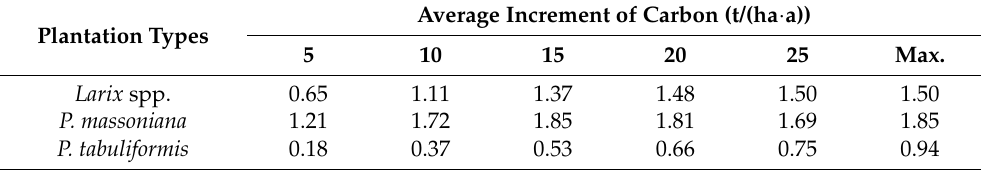
plantation types.